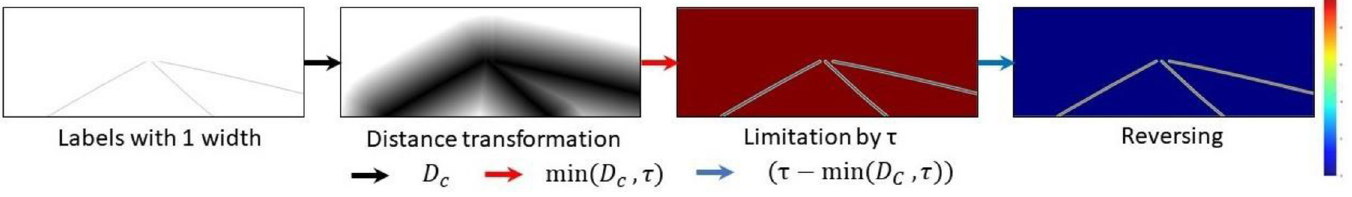
Fig 2. Process of obtaining geometric distance transformation